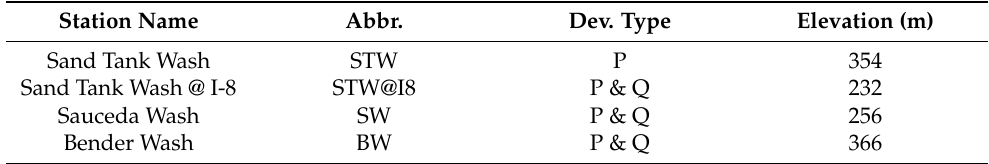
Table 2. Precipitation (P) and streamflow (Q) gauges operated by